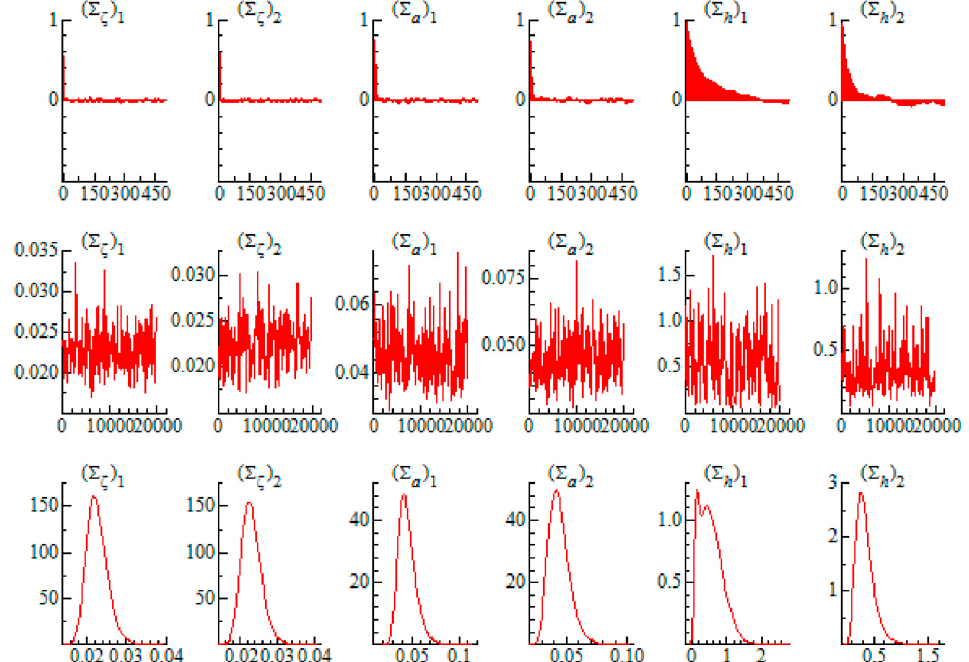
Figure 3. Estimation results of parameters in the TVP-VAR model (bank credit–housing prices). Notes: The figure shows sample auto-correlations ( top ), sample paths ( middle ), and posterior densities ( bottom ). In the top figures, the x -axis is the sample auto-correlation, and the y -axis is the lag; in the middle figures, the x -axis is the sampled value, and the y -axis is the iteration; in the bottom figure, the x -axis is the probability density, and the y -axis is the sampled value. The estimates of Σ ζ and Σ a are multiplied by